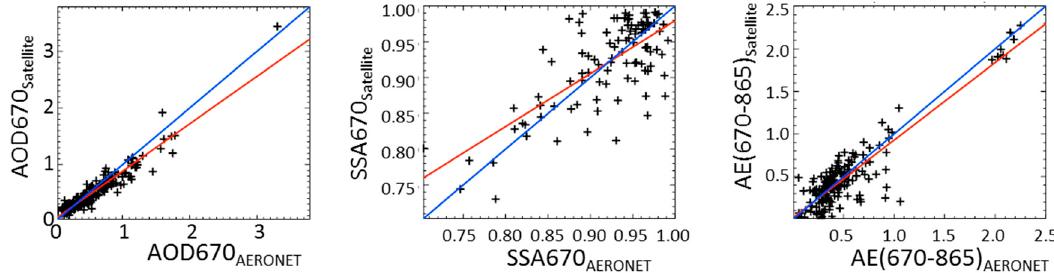
Figure 10. Comparison of GRASP/PARASOL retrieved parameters AOD, AE and SSA at 670 nm vs. AERONET station measurements over sites Mongu, Banizoumbou, IER_Cinzana, Agoufou, Ilorin, DMN_Maine_Soroa in Africa for 2008. The red lines show the linear regression fit.